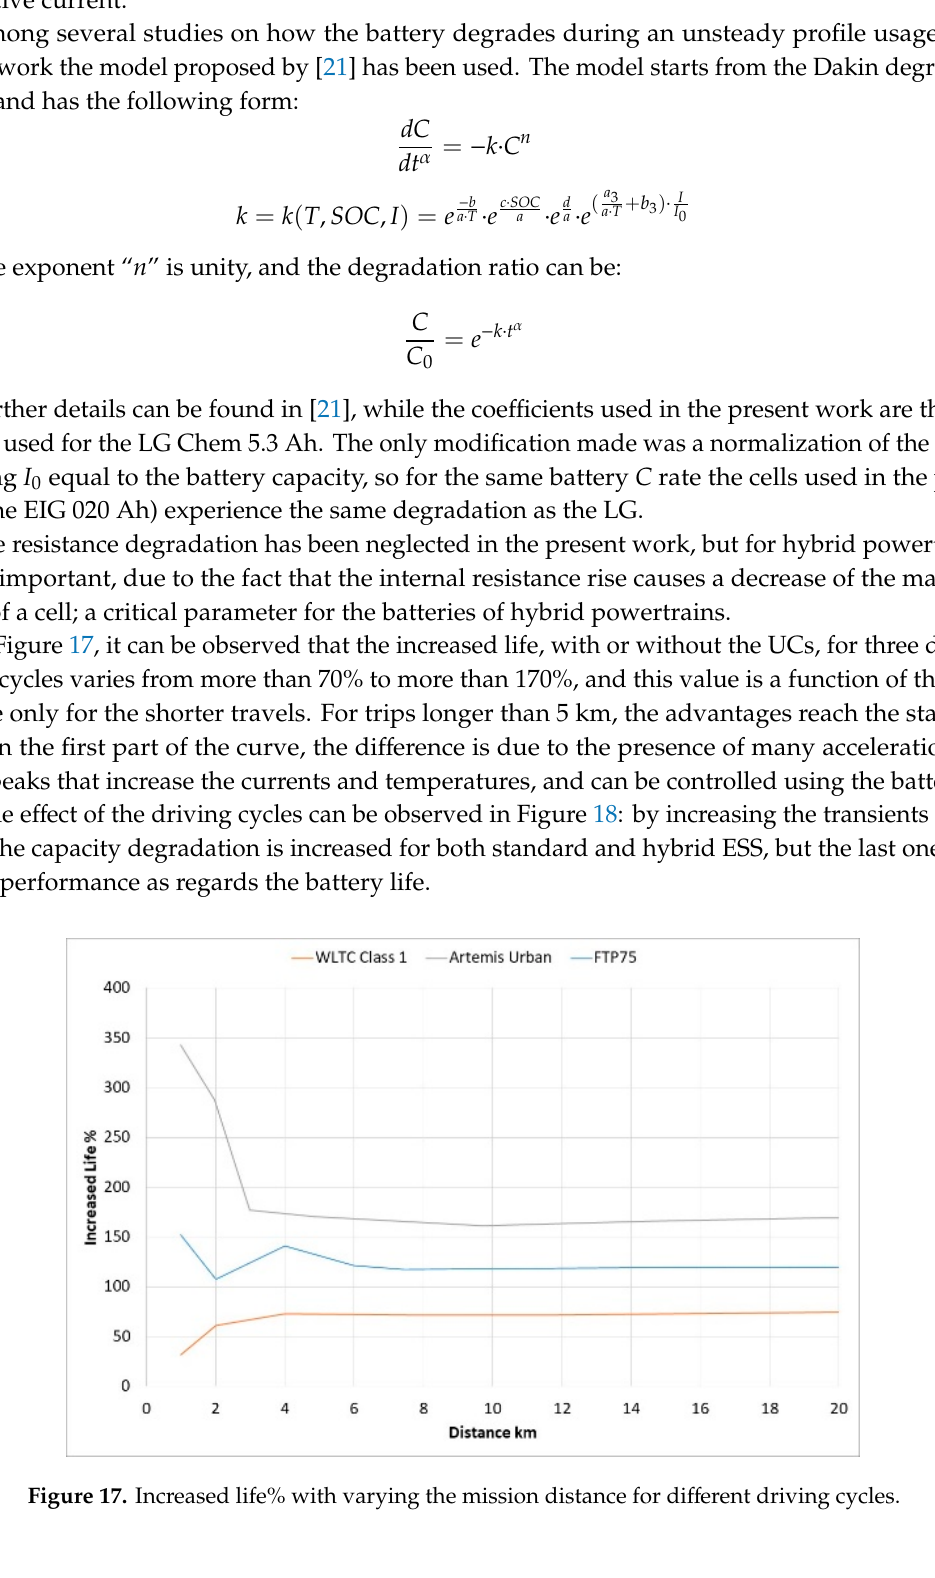
Figure 18. Absolute degradation for different driving cycles after 10 km, with and without UCs.